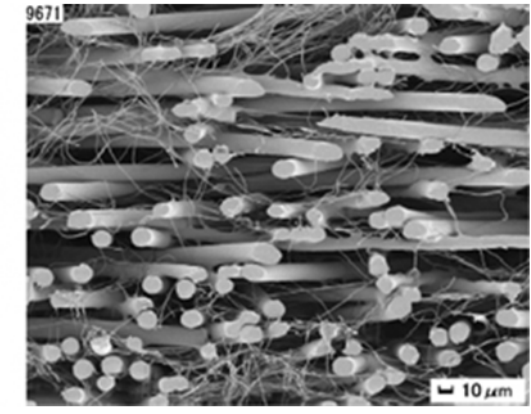
Fig. 16. Cross-section of a fabric made from a 30% blend of 700 nm diameter and standard microfibers. Reprinted by permission from Macmillan Publishers Ltd.